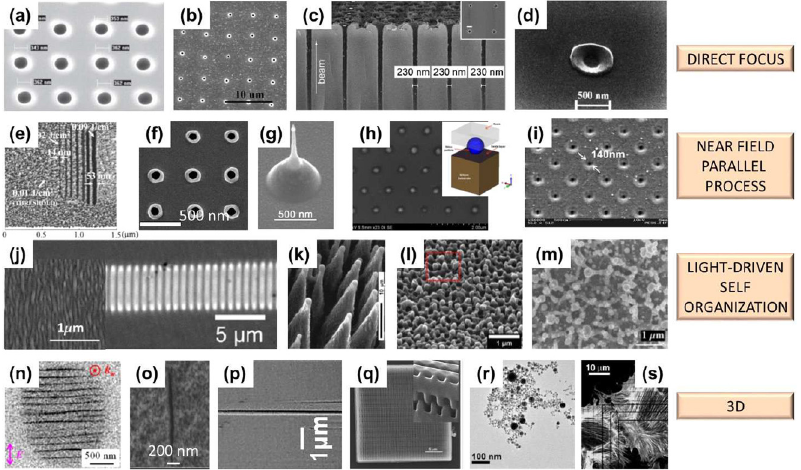
Figure 1: Example of ultrafast laser